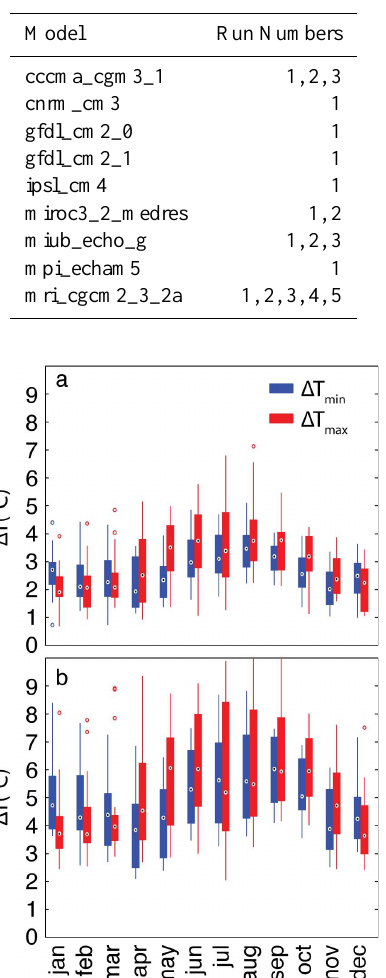
Table 1. CMIP-3 models used to develop the delta perturbations.